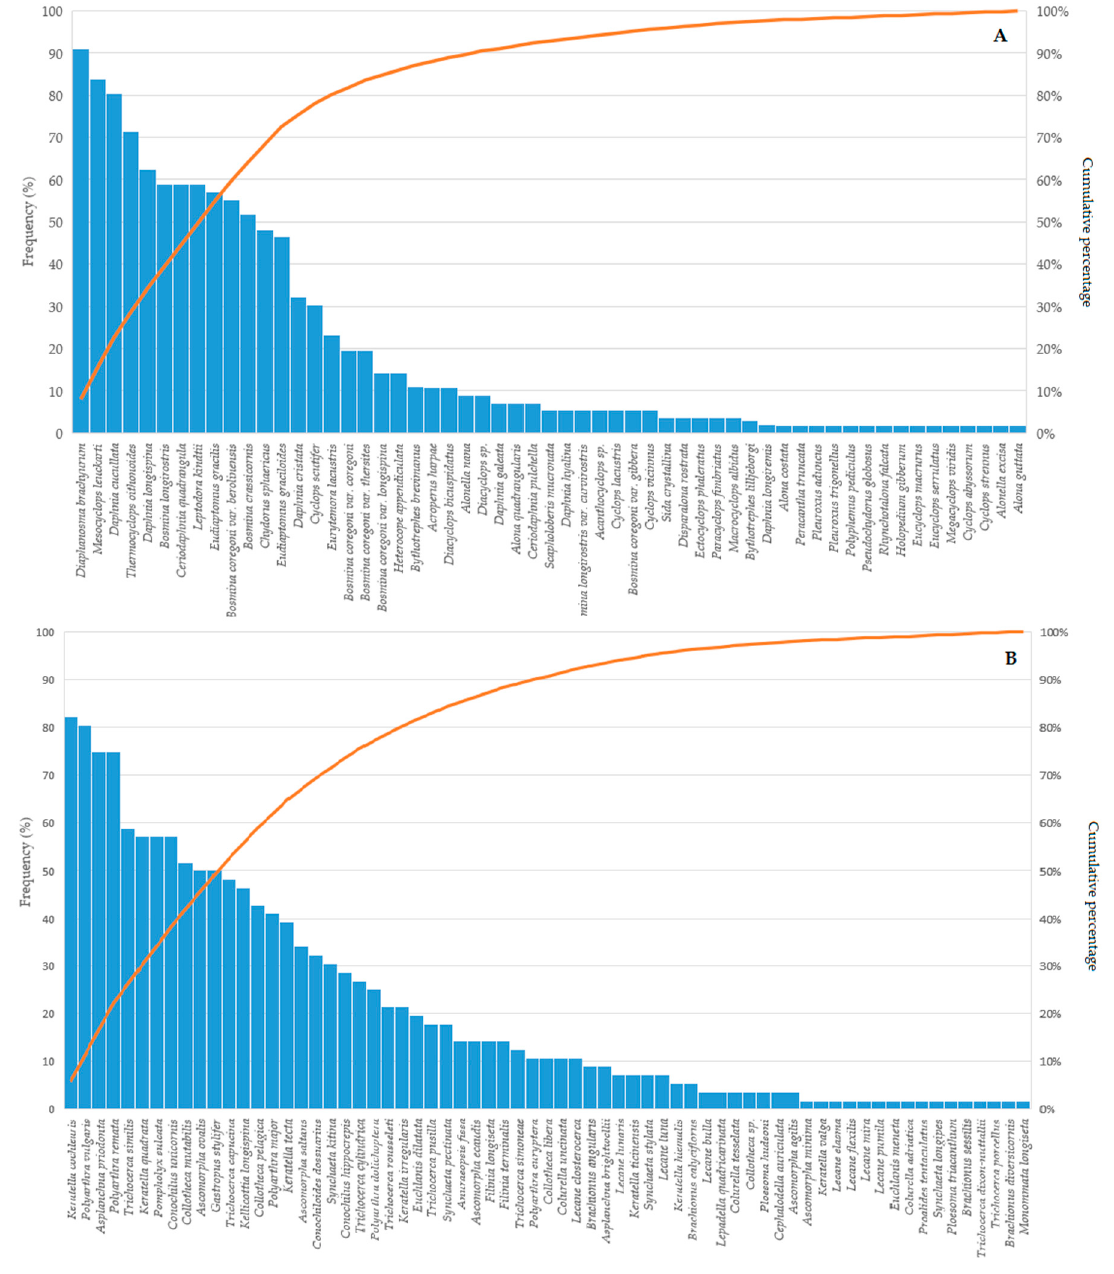
Figure 1. The frequency of Crustacea ( A ) and Rotifera species ( B ) in lakes of north-eastern (NE) Poland presented as Pareto charts. Both charts present a full list of species.